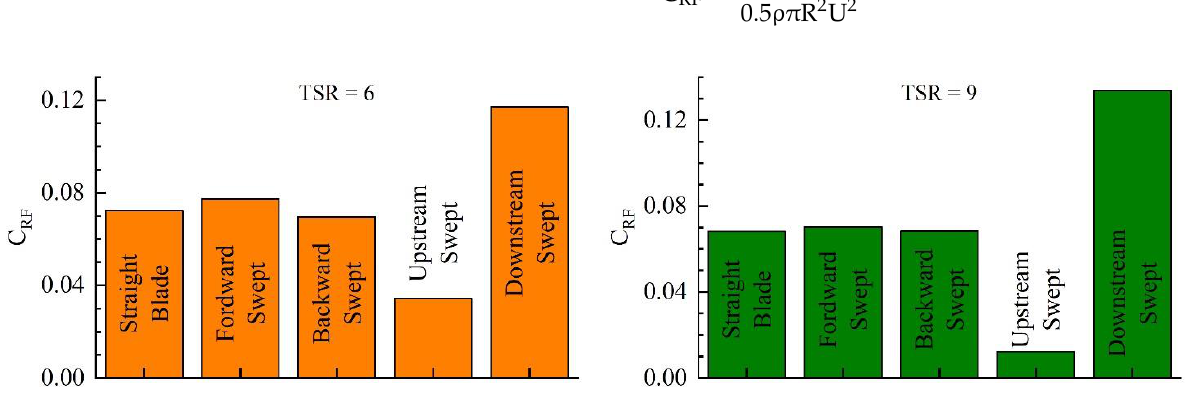
Figure 17. Radial force from one blade on the flow.